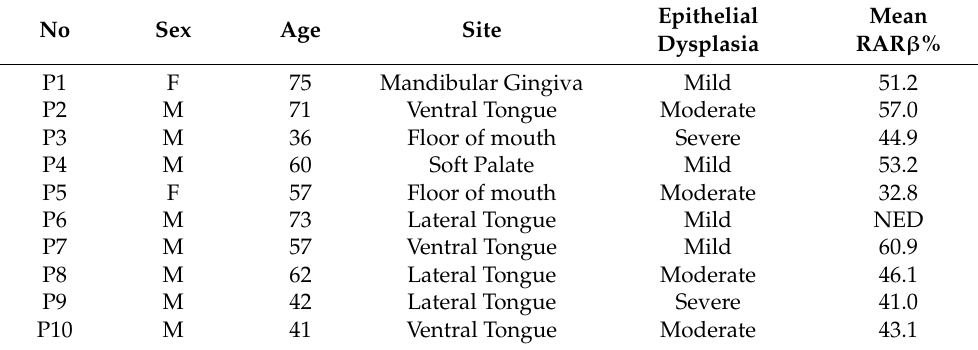
Table 2. Details of the extended OED patient